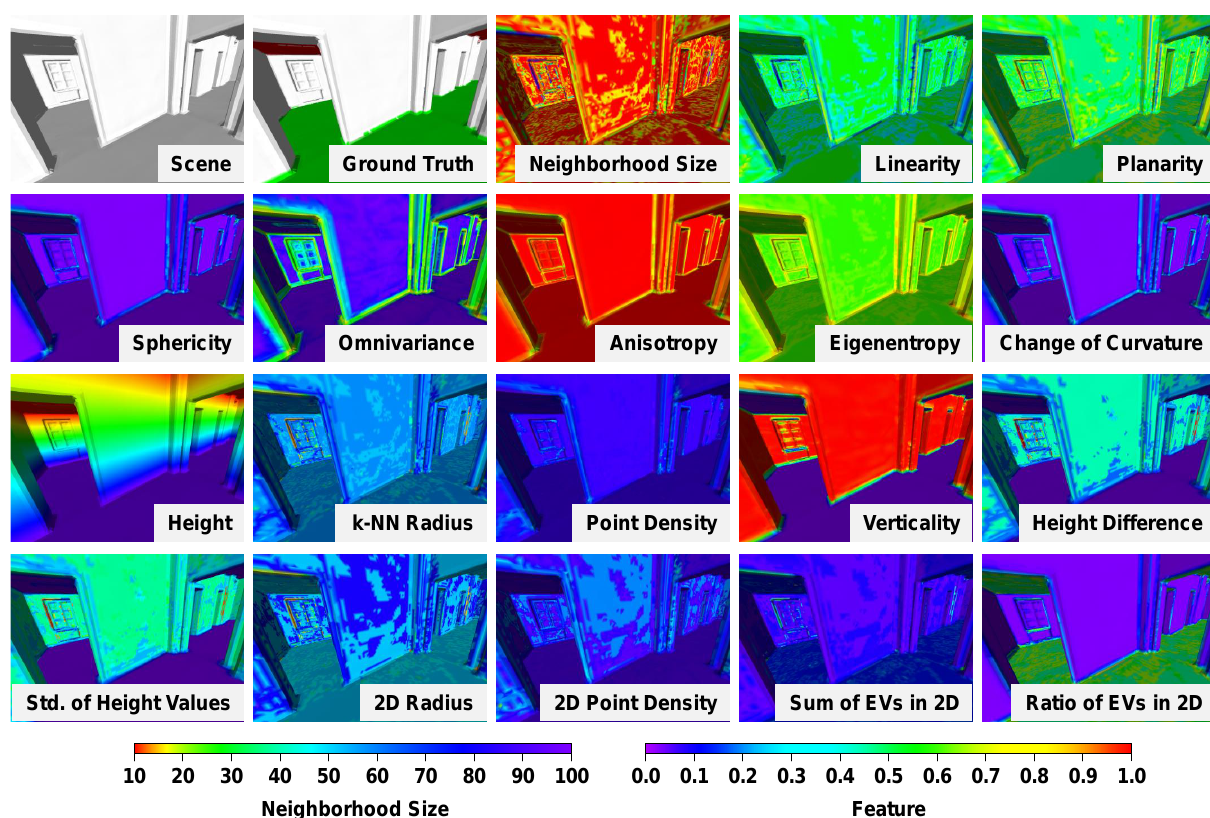
Figure 4. Visualization of the scene, the ground truth labeling, the neighborhood size, and the 17 considered features (scaled to [0 , 1] ) for the TLS dataset.